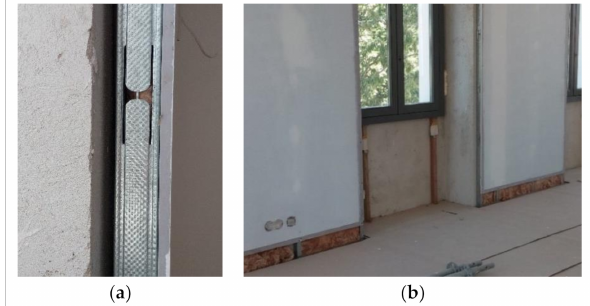
Figure 2. Application of an internal thermal retrofitting solution: ( a ) insulating boards of mineral wool coated with gypsum plasterboard; ( b ) auxiliary structure which leads to the creation of a cavity between the wall and the thermal insulation (case